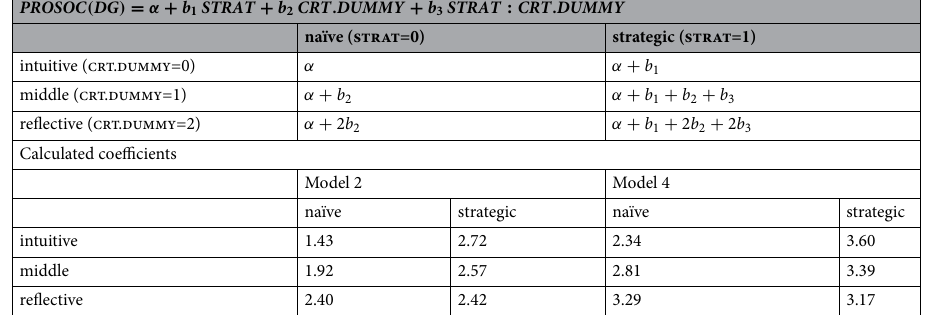
Table 7. Theoretical and estimated coefficients: Model 2, Model 4. Theoretical coefficients indicate how to calculate the coefficients related to each type of subject according to the two classifications (Strategic- reflective), using the estimated coefficients from Equation (1) and reported in Table 6. To obtain the exact values of the coefficients of the table, both calculated and theoretical, it is necessary to substitute the values of strat (0,1) and crt.dummy (0,1,2) in the equation at the top of the table, to obtain the resulting composed coefficients presented later in the Table, and using the estimated values of the regression of Table 6.